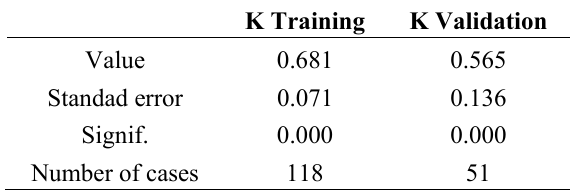
Table 10. Cohen’s Kappa index (K) for both training and validation